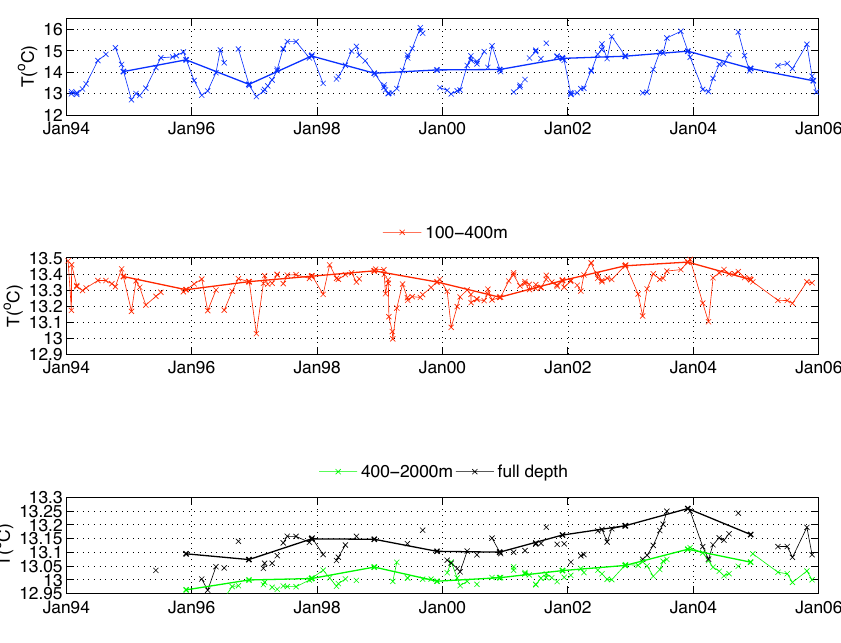
Fig. 4. Temperature ( ◦ C ) from Dyfamed for the 0-100m (top), the 100-400m (middle), the 400-2000m (bottom, green) and the 0-2000m (bottom, black) layers. For each plot, the corresponding thick line joins the interpolated values for the 1 st of December of each year between 1995 and 2004.